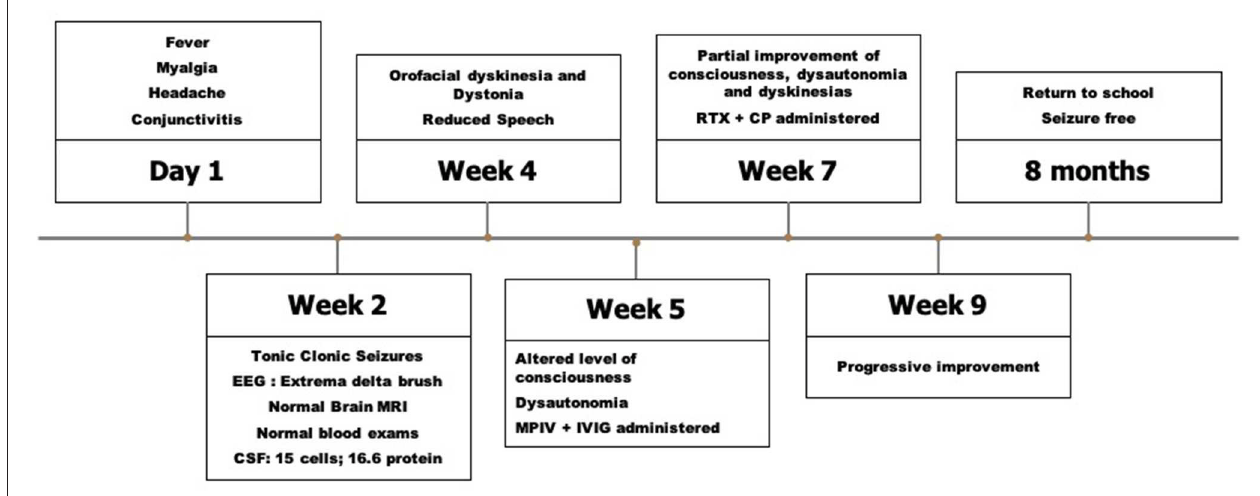
FIGURE 1 | Timeline of clinical features, investigation and treatment of the case report. CSF, Cerebrospinal fluidl; MPIV, Intravenous methylprednisolone; MRI, Magnetic resonance imaging; IVIG, Intravenous immunoglobulin; RTX, Rituximab; CP,